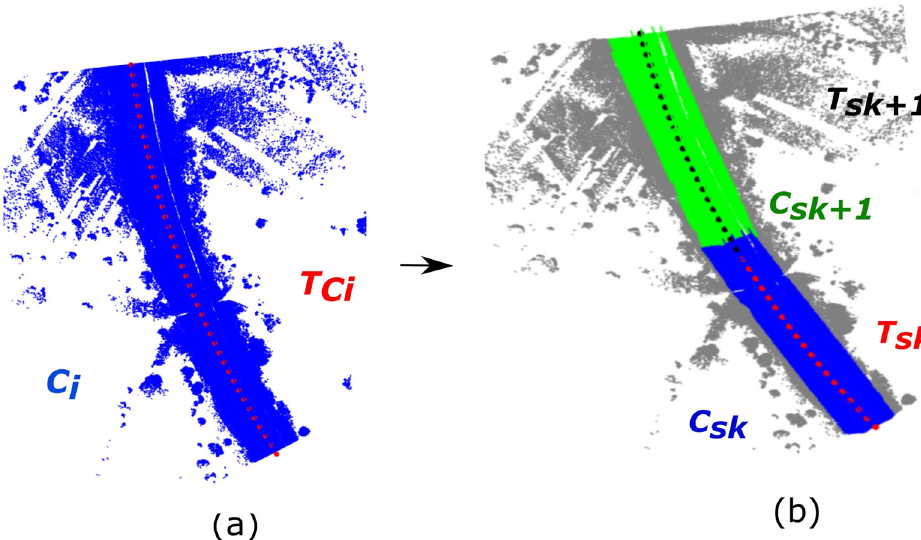
Figure 3. Sectioning workflow: ( a ) point cloud C i with its corresponding trajectory section T Ci ; ( b ) C i is sectioned in C sk and C s ( k + 1 ) with its corresponding T sk and T s ( k + 1 ) . C i points that are not part of any section are coloured in grey.